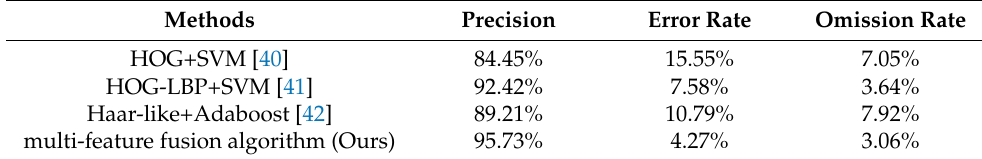
Table 2. Detection performance under complex weather conditions (five-fold crossvalidation